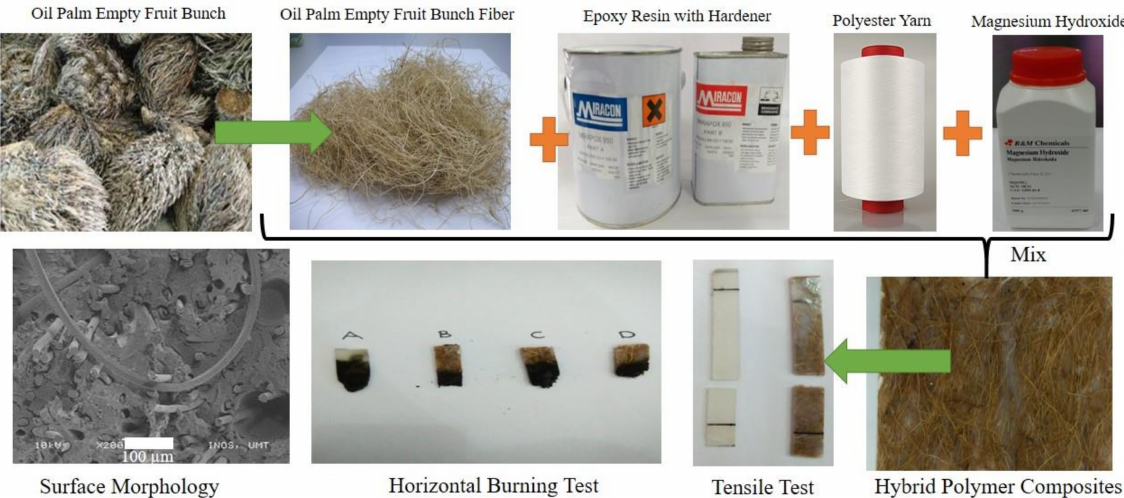
Figure 5. Extraction of OPEBF, and fabrication of OPEBF/polyester yarn, magnesium hydroxide reinforced epoxy resin hybrid composite. Extracted from [69] with